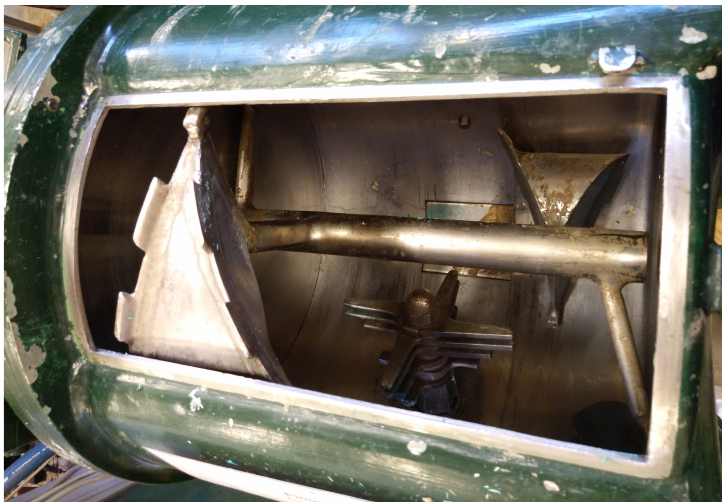
Figure 1. Resonating mixer used for particleboard production in laboratory